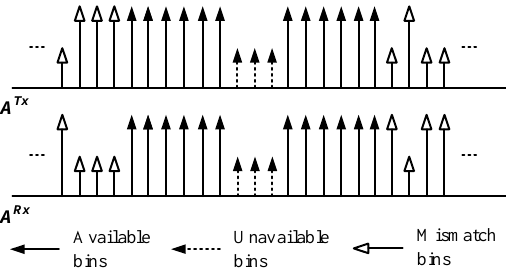
Figure 5. An example of spectrum sensing mismatch.